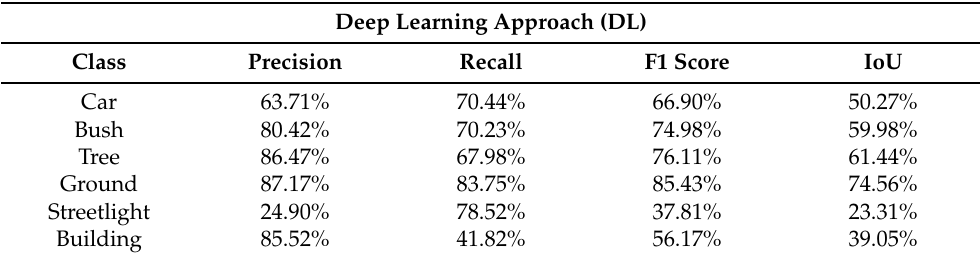
Table 1. Results of the statistics analysis of the deep learning (DL) approach.